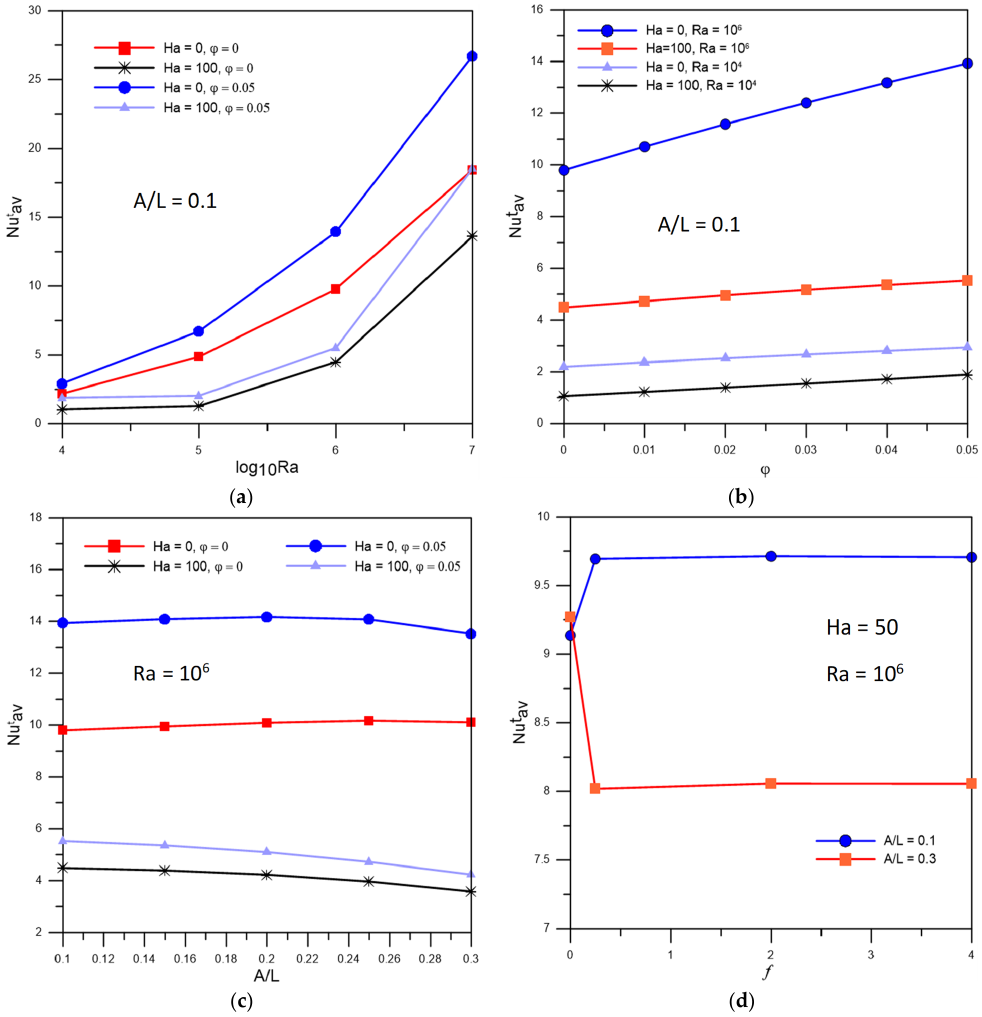
Figure 8. Effects of ( a ) Ra , ( b ) φ , ( c ) A/L and ( d ) f on Nu tav.